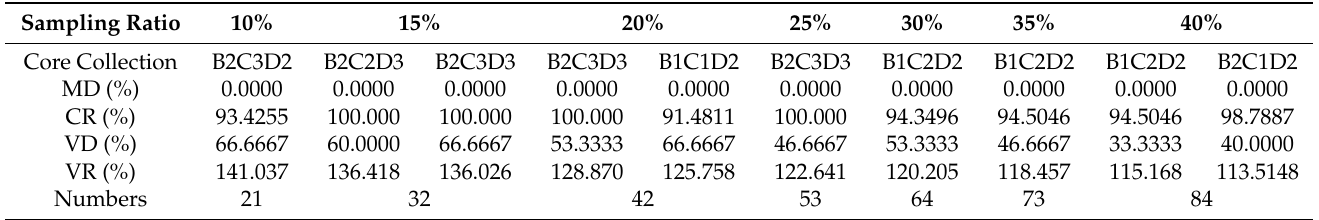
Table 5. Percentage of trait differences between the core and original collection under different sampling